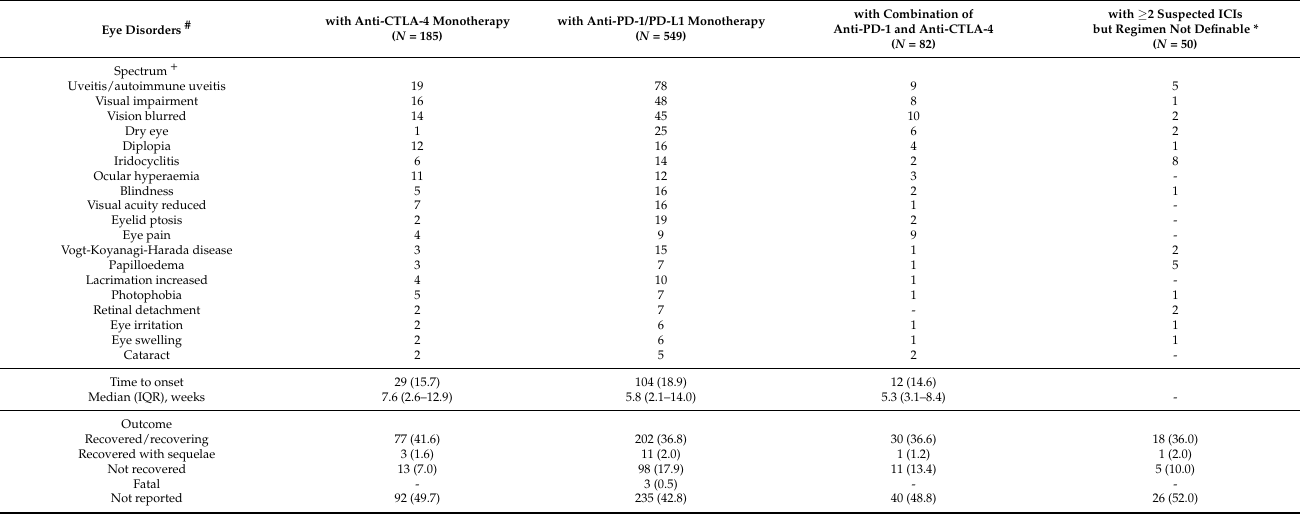
programmed cell death-ligand1; ATC, anatomical, therapeutic, chemical. Table 3. Spectrum, time-to-onset, and outcome of eye disorders reported with immune checkpoint inhibitors in the age subgroup 18–64